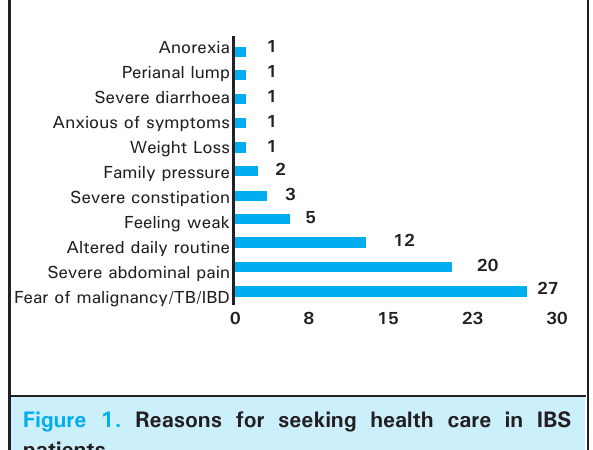
Figure 1. Reasons for seeking health care in IBS patients.